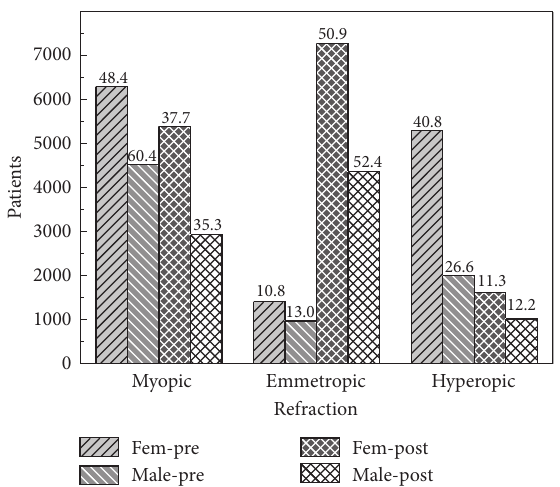
Figure 11: Classification of the refraction, preoperative and postoperative, segmented by